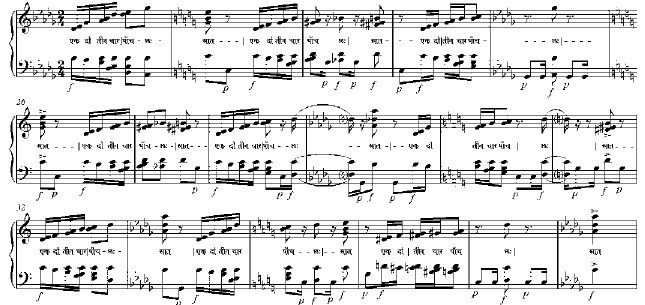
Figure 2: Textmusic #10 (excerpt bars